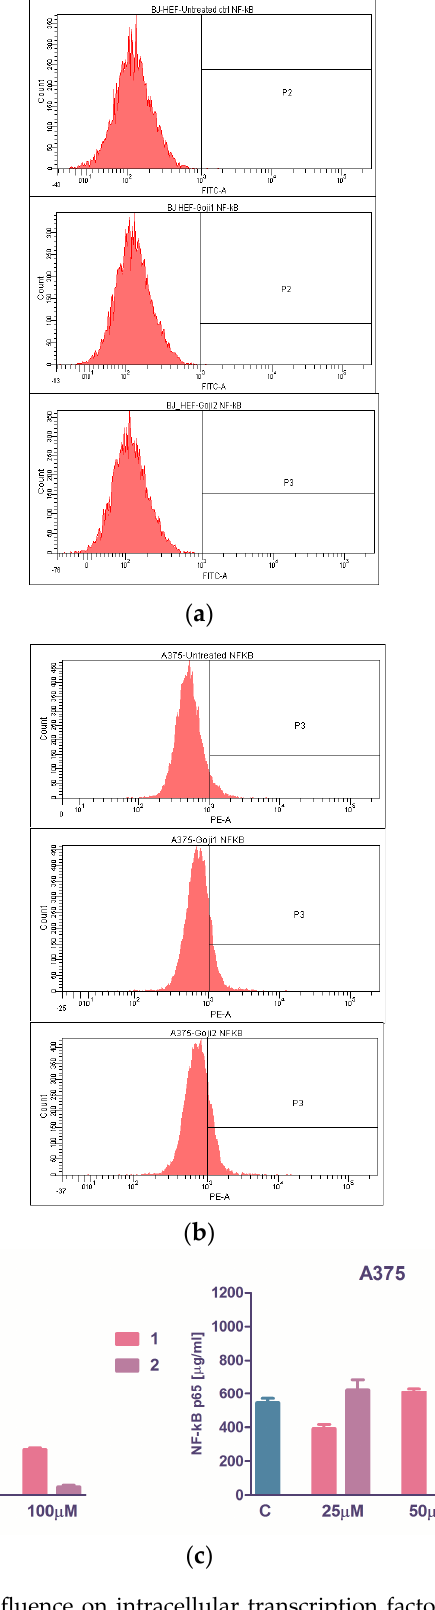
Figure 5. The zeaxanthin-rich extracts influence on intracellular transcription factor NF-k β p65 is depicted by flow-cytometry generated histograms of normal BJ ( a ) and malignant A375 cells ( b ) subjected to a 24-h treatment; from left to right: untreated cells, treatment with 50 μ M 1 and 2 . ( c ) The dose-response relationship between the quantity of zeaxanthin added to the cells and the concentration of the soluble NF-k β p65 secreted within 24